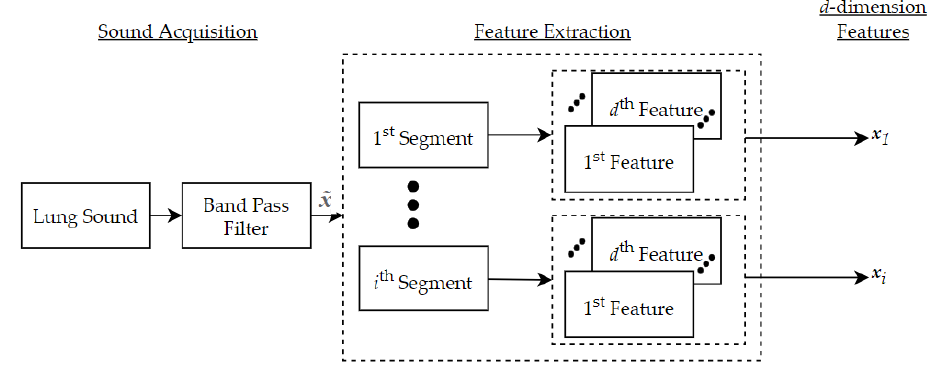
Figure 1. Proposed embedded architecture for the K-MDC feature extraction.